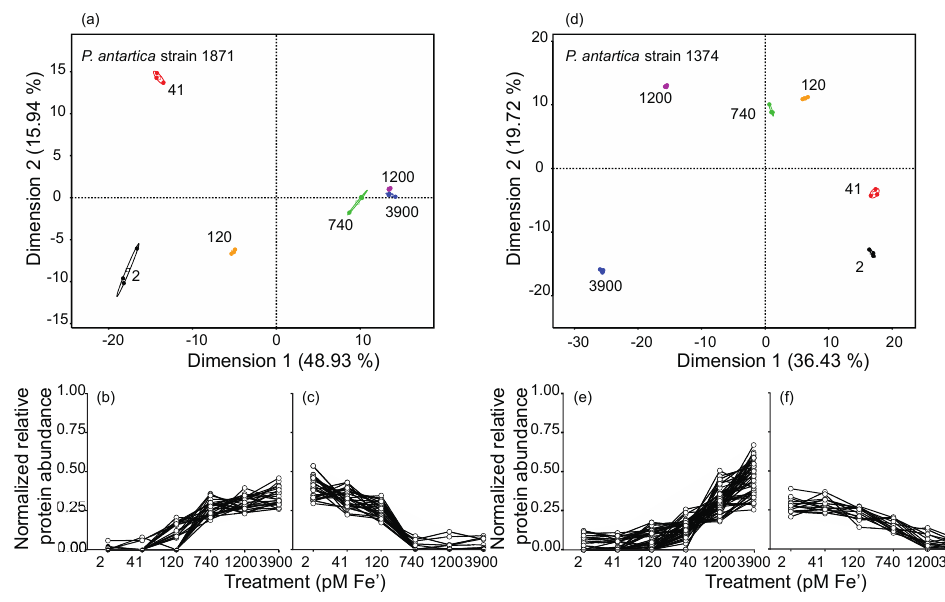
Figure 4. Principal component analysis (PCA) of the measured proteomes for each iron condition for strain 1871 and strain 1374 and corresponding line graphs highlighting the proteins driving the PCA separation (PCAs: ≥ 0 . 9 or ≤ − 0 . 9). (a, d) Iron treatments (pM Fe’) are highlighted by color (2, black; 41, red; 120, orange; 740, green; 1200, purple; 3900, blue) and large ellipses indicate confidence ellipses calculated using the R package FactoMineR. Each small solid circle represents a technical replicate per iron treatment ( n = 3); colored open squares represent the mean of the iron treatment (empirical variance divided by the number of observations). Proteins with eigenvalues ≥ 0 . 9or ≤ − 0 . 9 are plotted in graphs b and c for strain 1871 and (e) and (f) for strain 1374 to highlight the subset of proteins driving the variance in Dimension 1. Individual protein spectral counts normalized to total spectral counts for all treatments for a given protein, written as “normalized relative protein abundance”, are plotted on the y axis. The six iron treatments (pM Fe’) are plotted from low to high (left to right) on the x